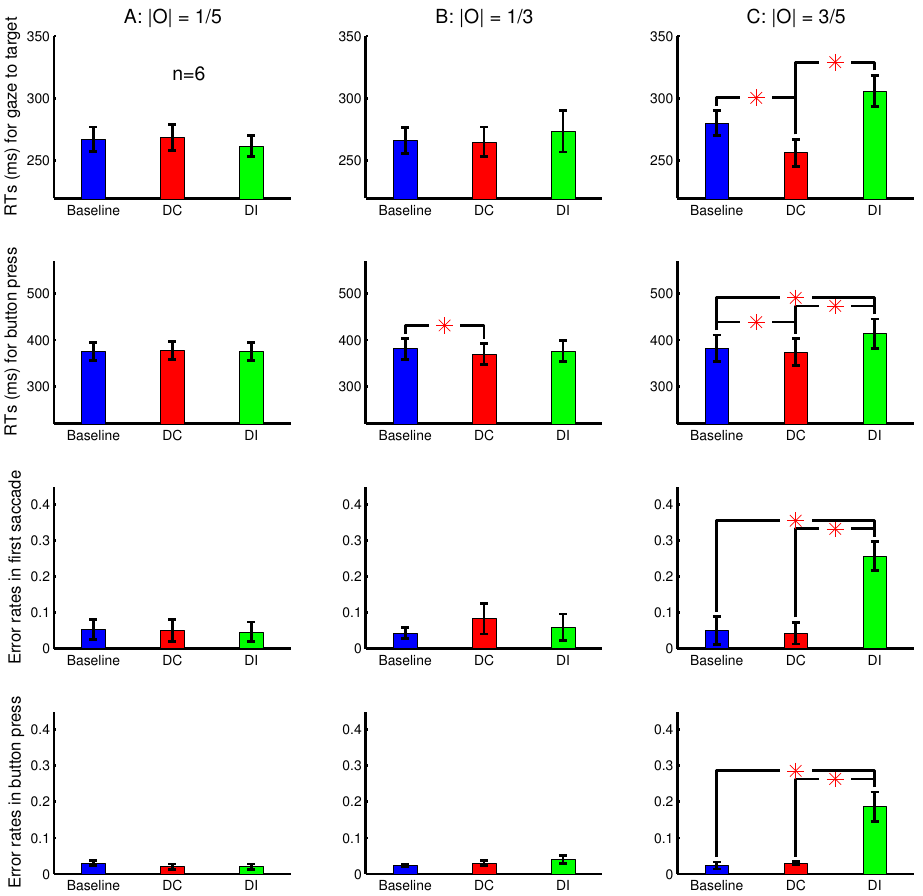
Figure 5. The attentional attraction by the ocularity singleton bar increases with the ocularity contrast between this singleton bar and other input bars. Shown here are behavioural results averaged over n = 6 observers in the task to search for a uniquely oriented bar in 23 rows by 23 columns of bars, with the target bar and non-target bars tilted 45 ◦ in opposite directions from vertical. All the bars in a single O trial shared the same ocularity magnitude , which can be weak ( A ) (left column), intermediate ( B ) | | (middle column), or strong ( C ) (right column). The ocularity singleton (in a DC or DI trial) had the s R among the bars in a trial, making the ocular contrast 2 O unique sign of this ocularity O = s L . − | | Shown are the RTs for the gaze to reach the target (top row) or for the button press (second row) and the error rates in the first saccade (third row) and button press (bottom row). Each subject’s data were from an experimental session in which the trials from the nine conditions (baseline, DC, and DI in each of (A–C)) were randomly interleaved. The first saccade during a search was deemed erroneous when it went to the left or right from the central fixation (in the perceived image) when the target was to the right or left,